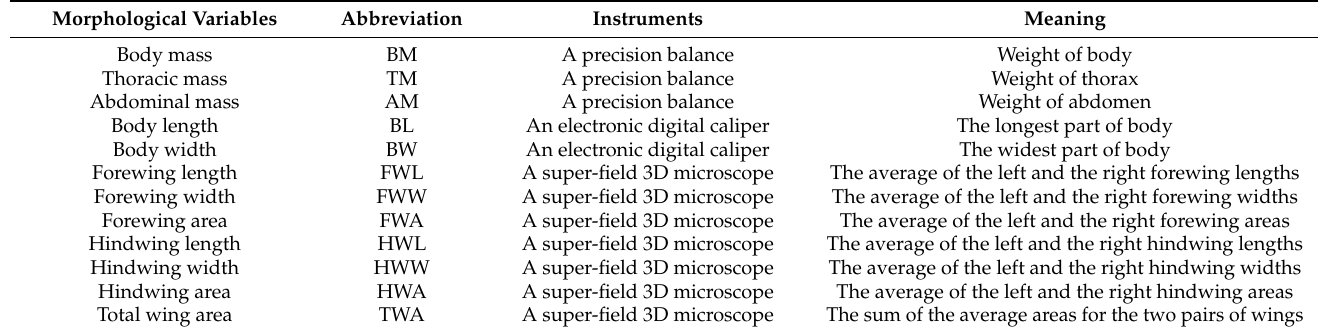
Table 1. Twelve morphometrics of insect body parts measured in this experiment.